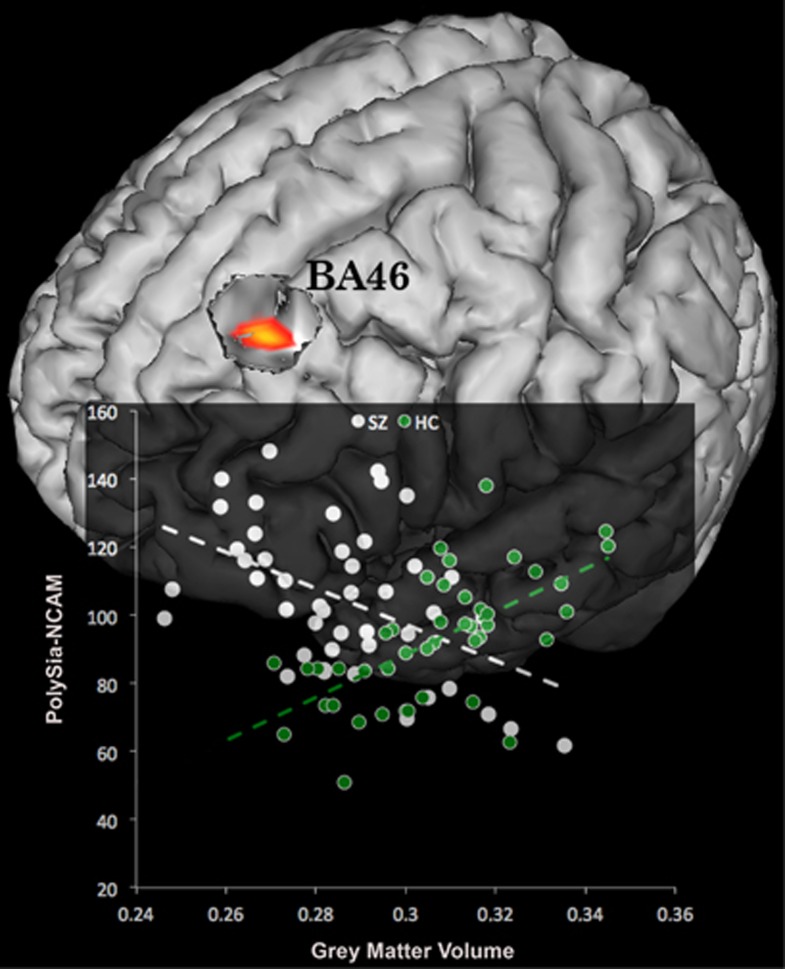
Relationship between neural cell adhesion molecule (NCAM) serum levels and gray matter volume in healthy control (HC) and schizophrenia (SZ). The statistical result (red-to-yellow map) is superimposed over a three-dimensional rendering of the Montreal Neurological Institute standard brain. A scatterplot shows the differential relationship between NCAM and volume in the two study groups.